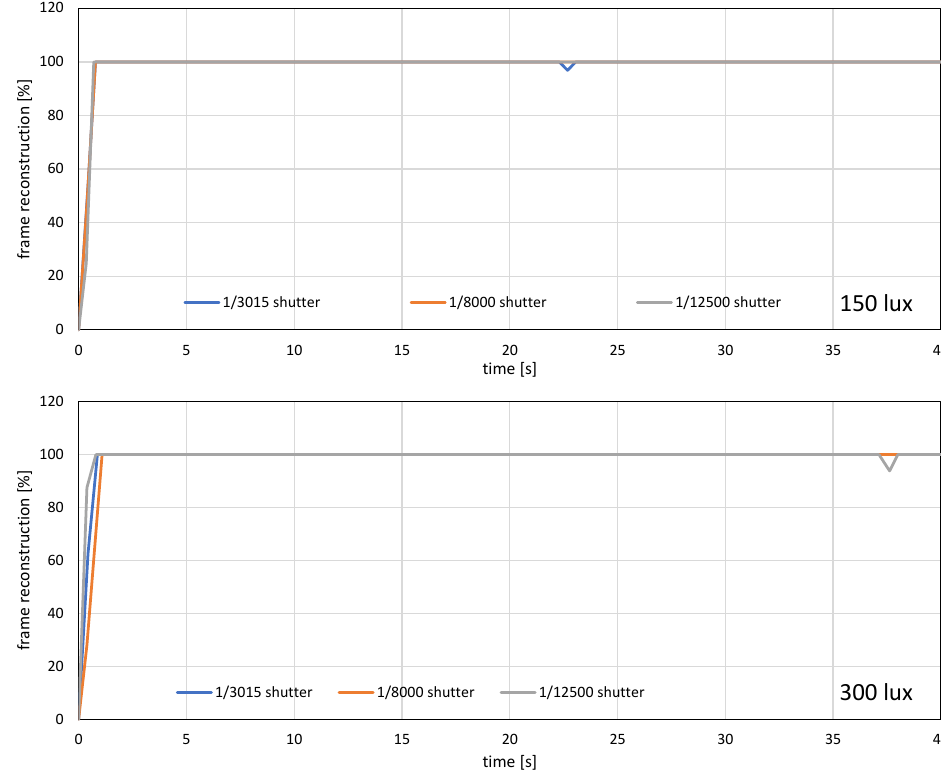
Figure 21. Frame reconstruction ratio when a stored movie is